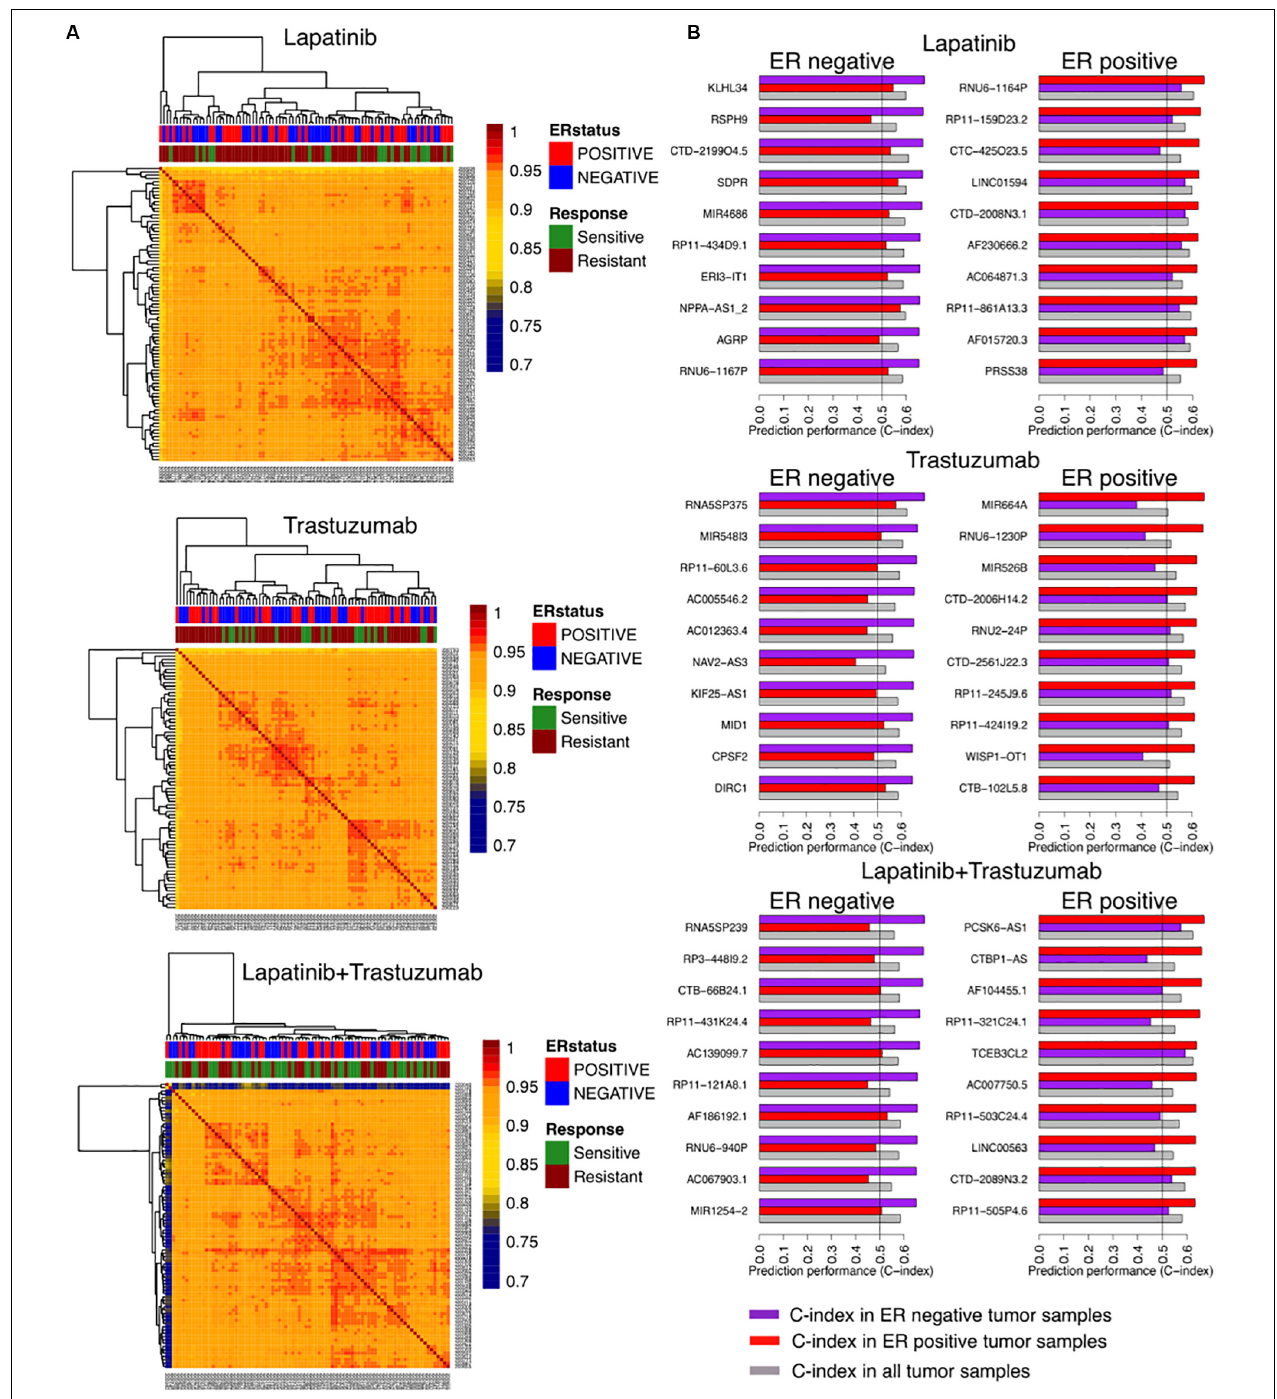
FIGURE 2 | Identifying responders to lapatinib, trastuzumab, and their combination therapy in the NeoALTTO clinical trial using genes as univariate predictors of response. (A) Clustering of samples based on their similarity, defined as the Spearman correlation between gene expression profiles of the sample. (B) Top 10 genes as univariate biomarkers of drug response in ER+ and ER– cohorts within each arm of the NeoALTTO clinical trial.